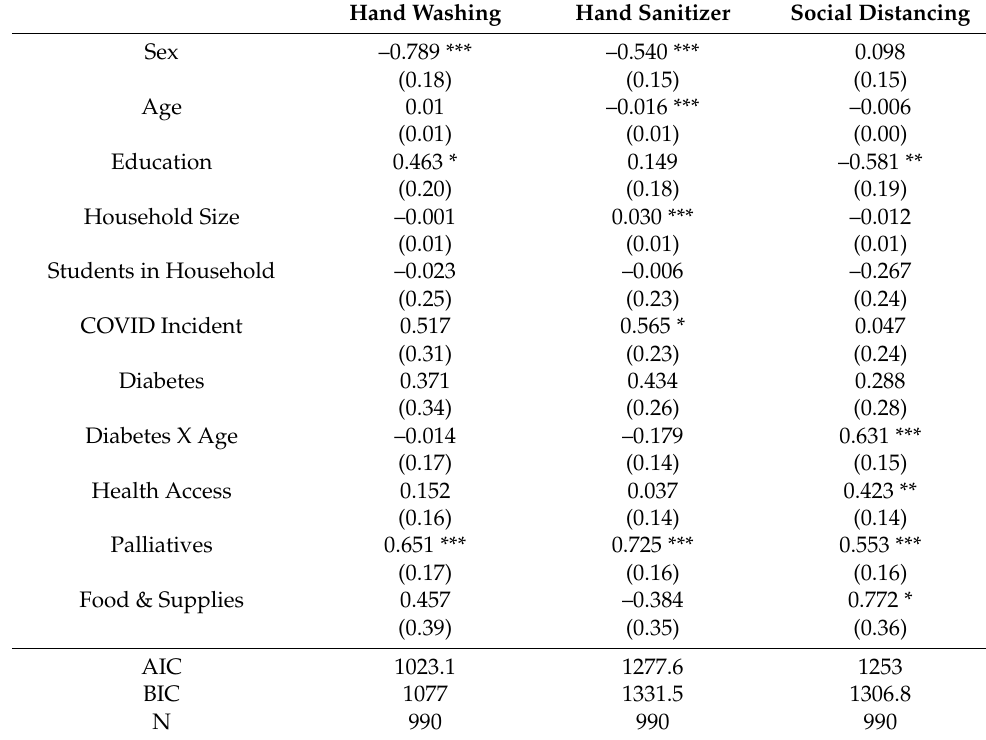
Table 5. Robustness check of the full model using other NPIs as dependent variable (Standard errors